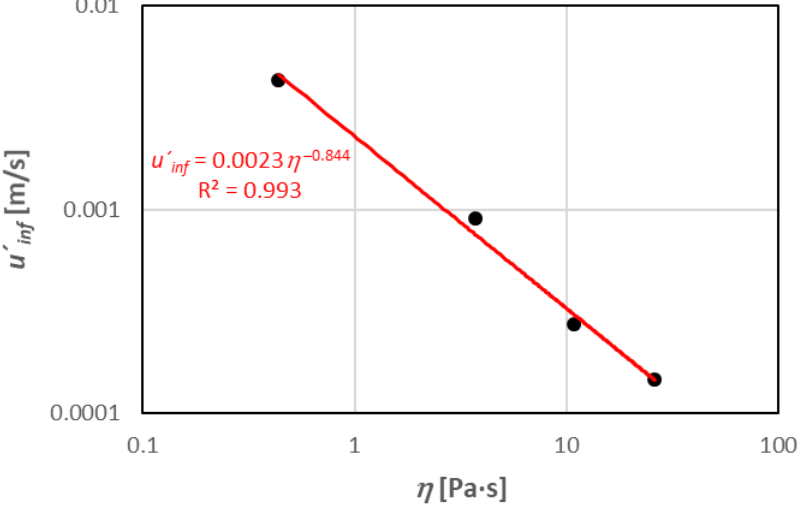
Figure 8. Dependence of the model parameter u´ inf according to Equation (5) on the apparent viscosity of the liquid phase of the suspension for a shear rate of 0.5 s −1 .